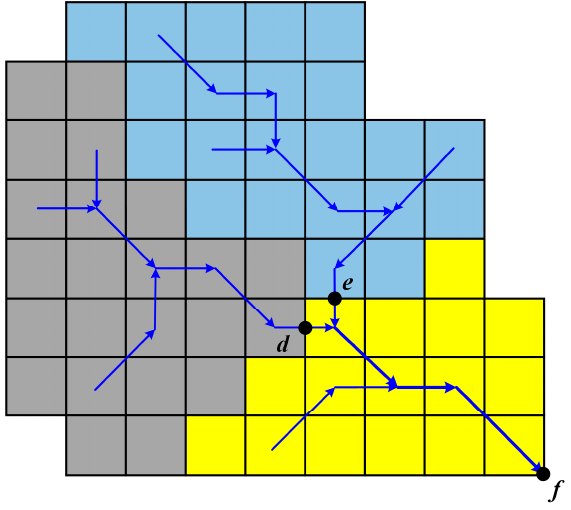
Figure 4. Discretization of catchment into sub-catchments and grids, and also delineation of streamflow routing (represented by blue lines) in the DEM-based rainfall-runoff model (DDRM). d , e , f represent the outlet of sub-catchments 1 (grey-shaded), 2 (light blue-shaded) and 3 (yellow-shaded), respectively.